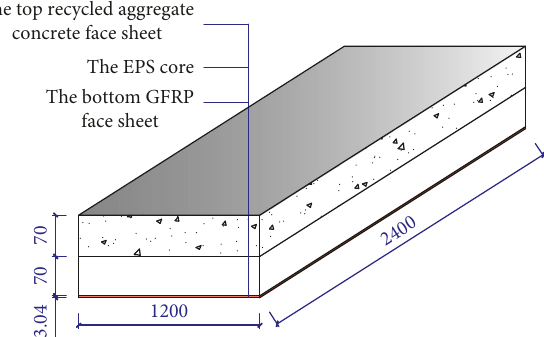
Figure 1: Schematic of the ICSIPs (unit: